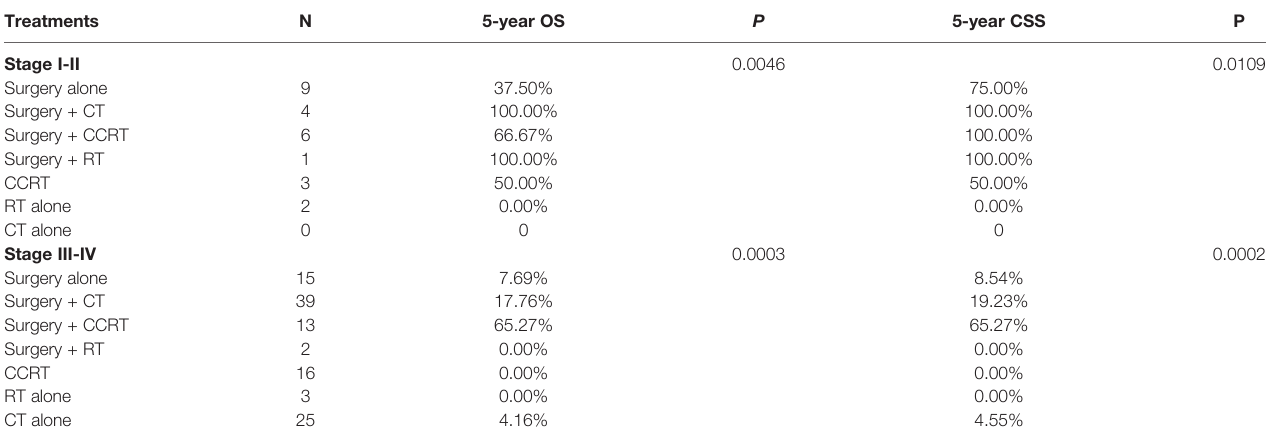
TABLE 4 | Five-year OS and CSS according to stage and treatment in patients with neuroendocrine tumors (NETs) of the endometrium. Treatments N 5-year OS P Stage